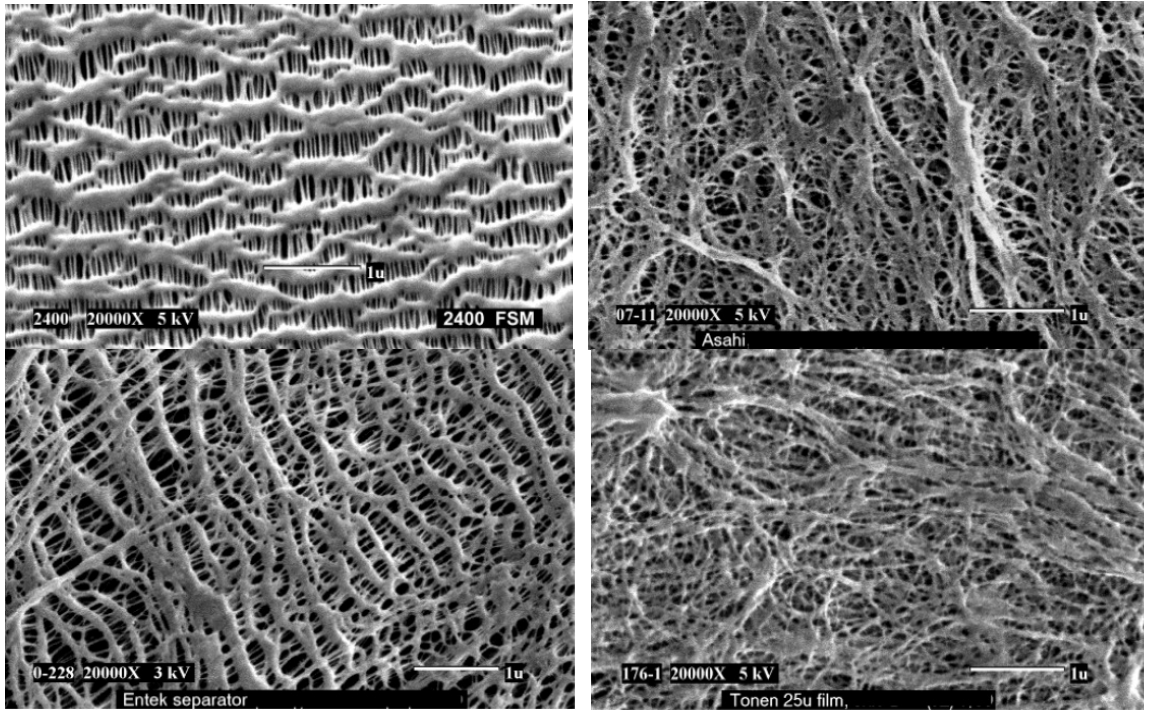
Figure 8. Scanning electron micrographs (SEMs) of ( a ) Celgard separator using dry process; ( b ) Asahi separator using wet process; ( c ) Entek separator using wet process; ( d ) Tonen separator using wet process [49].